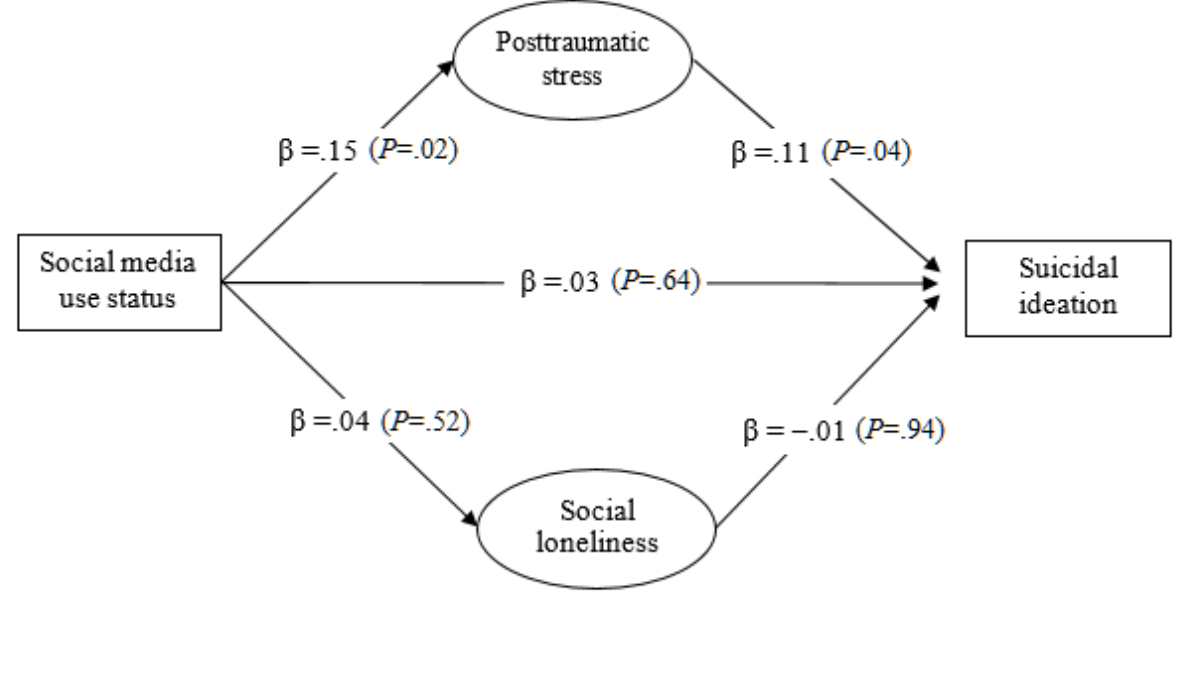
Figure 3. The proposed mediation model of suicidal ideation with standardized regression coefficients ( β ) among younger adults in Hong Kong during the COVID-19 pandemic